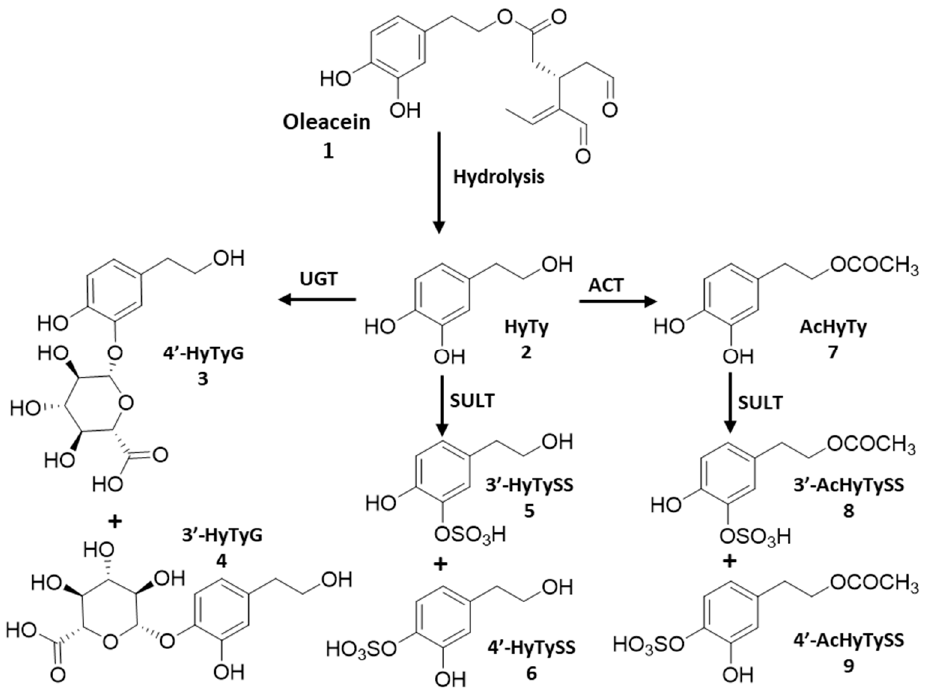
Figure 1. Olive oil polyphenol metabolites identified in bioavailability studies after oleacein consumption. Arrows may represent a direct or an indirect metabolic pathway. ACT—O-acetyltransferase; SULT—sulfotransferase; UGT—glucuronosyltransferase.